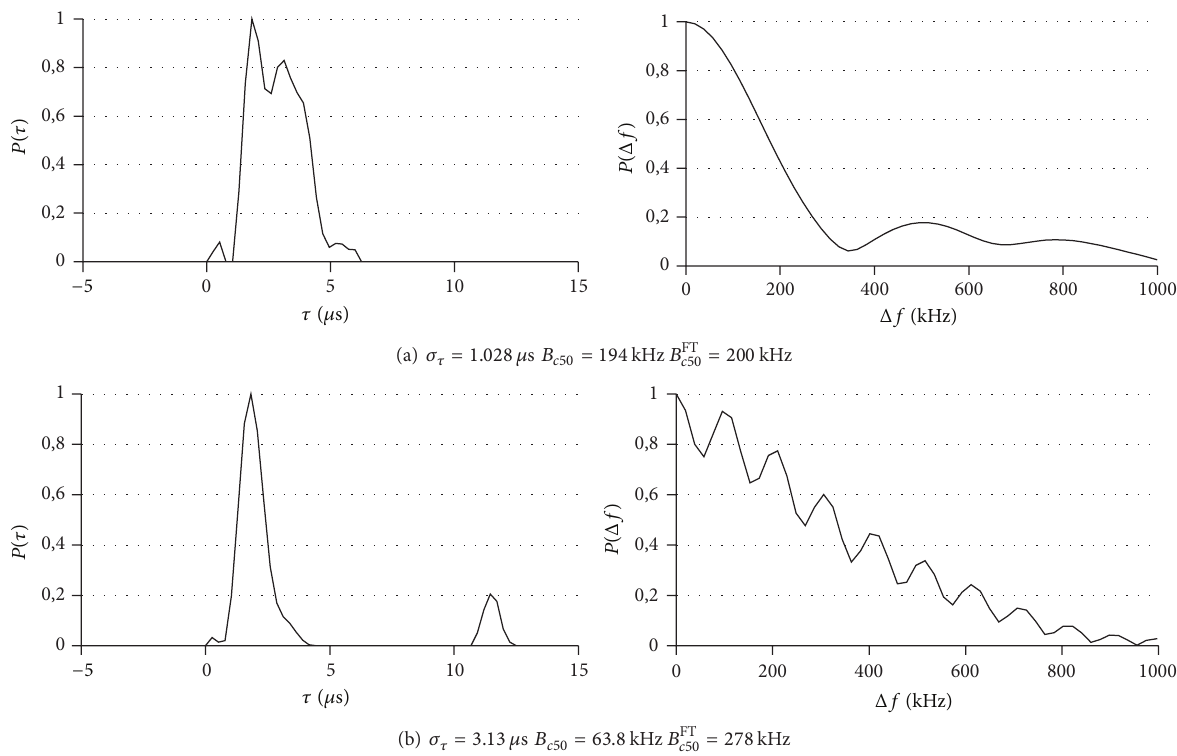
Figure 12: Examples of power delay profiles which gives similar (a) and different (b) values of coherence bandwidth.